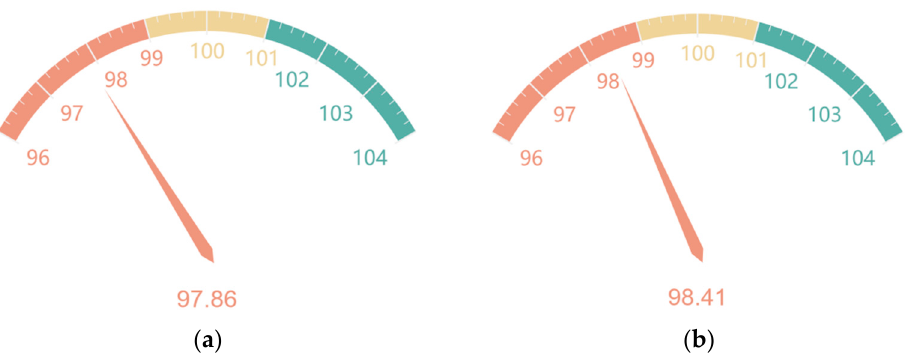
Figure 3. Globalization barometer. ( a ) De facto globalization barometer. ( b ) De jure globalization barometer.